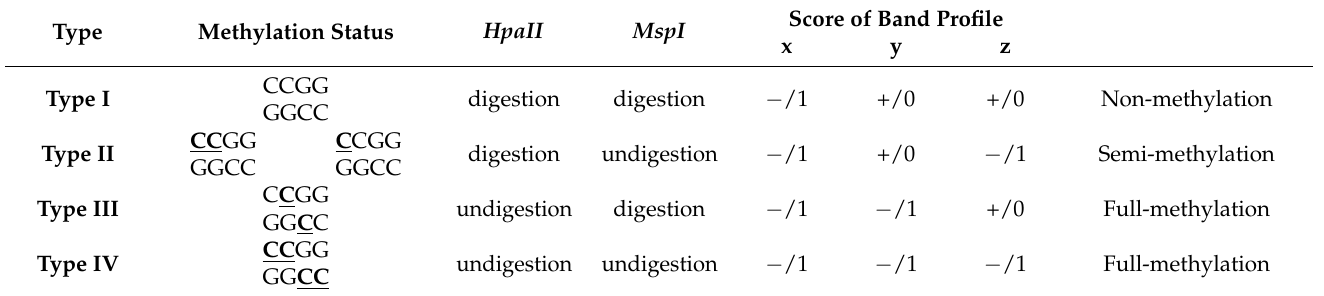
Table 1. Methylation types and patterns identified by HpaII and MspI restriction enzymes based on their digestion